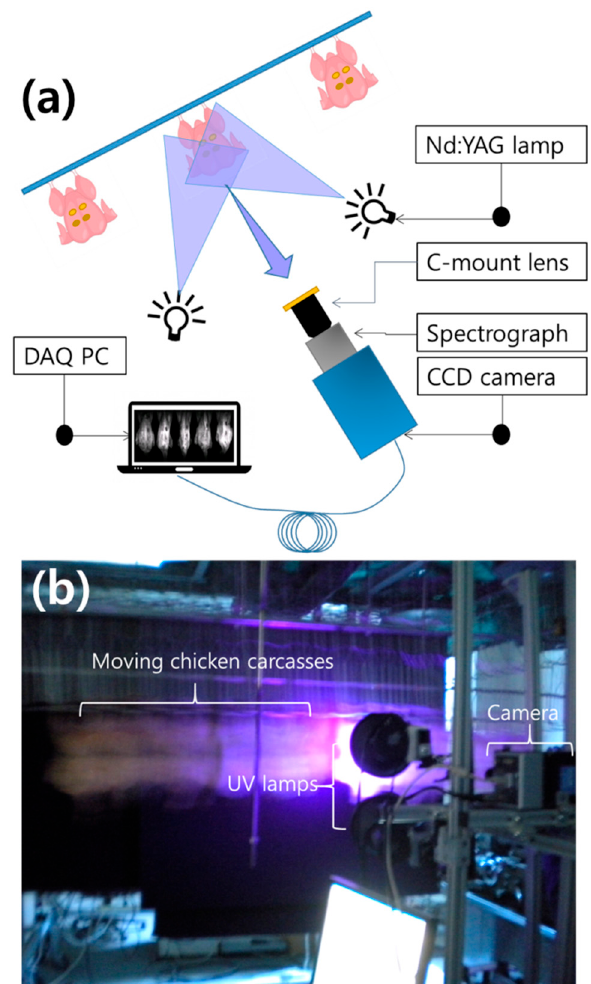
Figure 2. Schematic of the multispectral fluorescence imaging system ( a ) and a real-time multispectral fluorescence imaging system for detecting fecal matters on chicken surface ( b ).